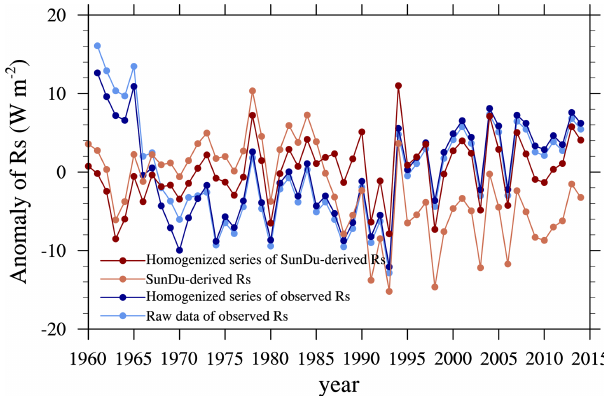
Figure 9. Time series of annual anomalies of the surface inci- dent solar radiation ( R s ) based on direct observations (light-blue line) and their homogenized series (dark-blue line) and sunshine- duration-derived (SunDu-derived) R s (light-red line) and their ho- mogenized series (dark-red line). All of the lines were calculated based on as many observations as possible. The light-blue line and dark-blue line were calculated from the R s observations at 105 sites, while the light-red line and dark-red line were derived from the SunDu-derived R s at 156 sites. The R s variations are nearly the same as those shown in Fig. 6, which were calculated based on the 41 selected sites in Sect. 3.1. Large discrepancies were found in the homogenized data series (dark-blue and dark-red lines).